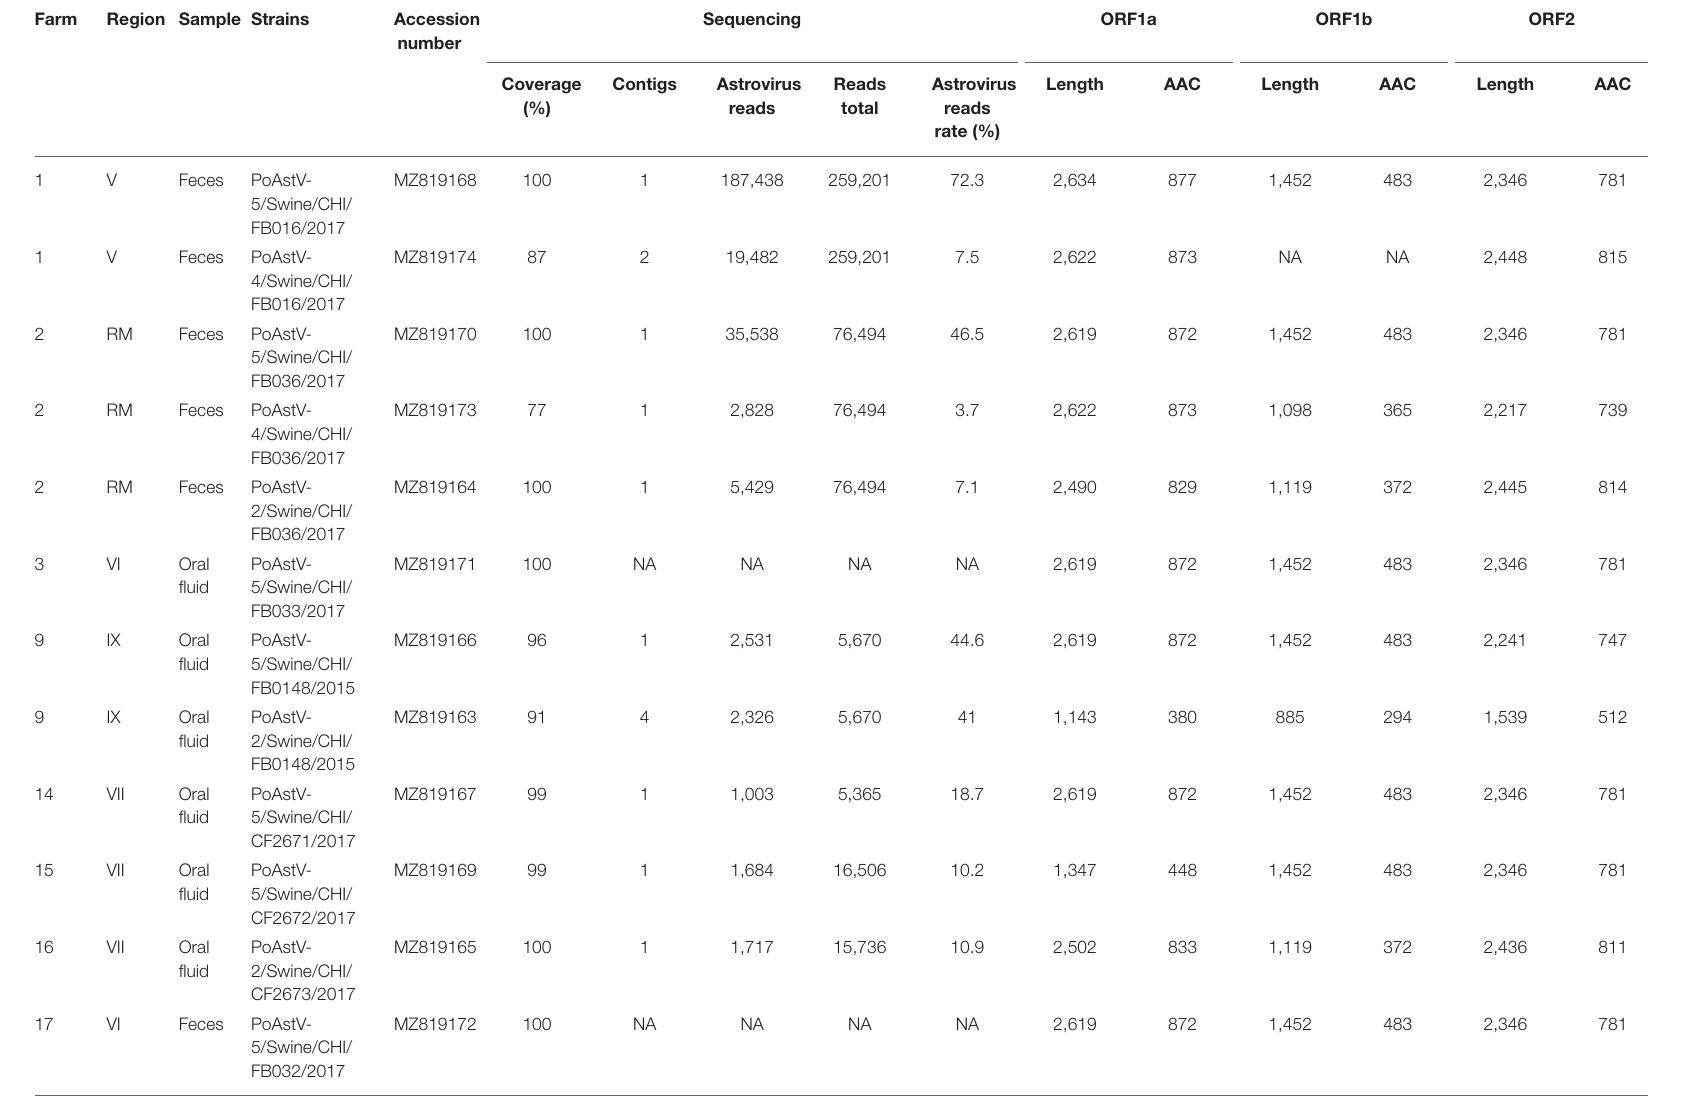
TABLE 1 | Summary of porcine astroviruses whole-genome sequencing results obtained from intensive farms in Chile.